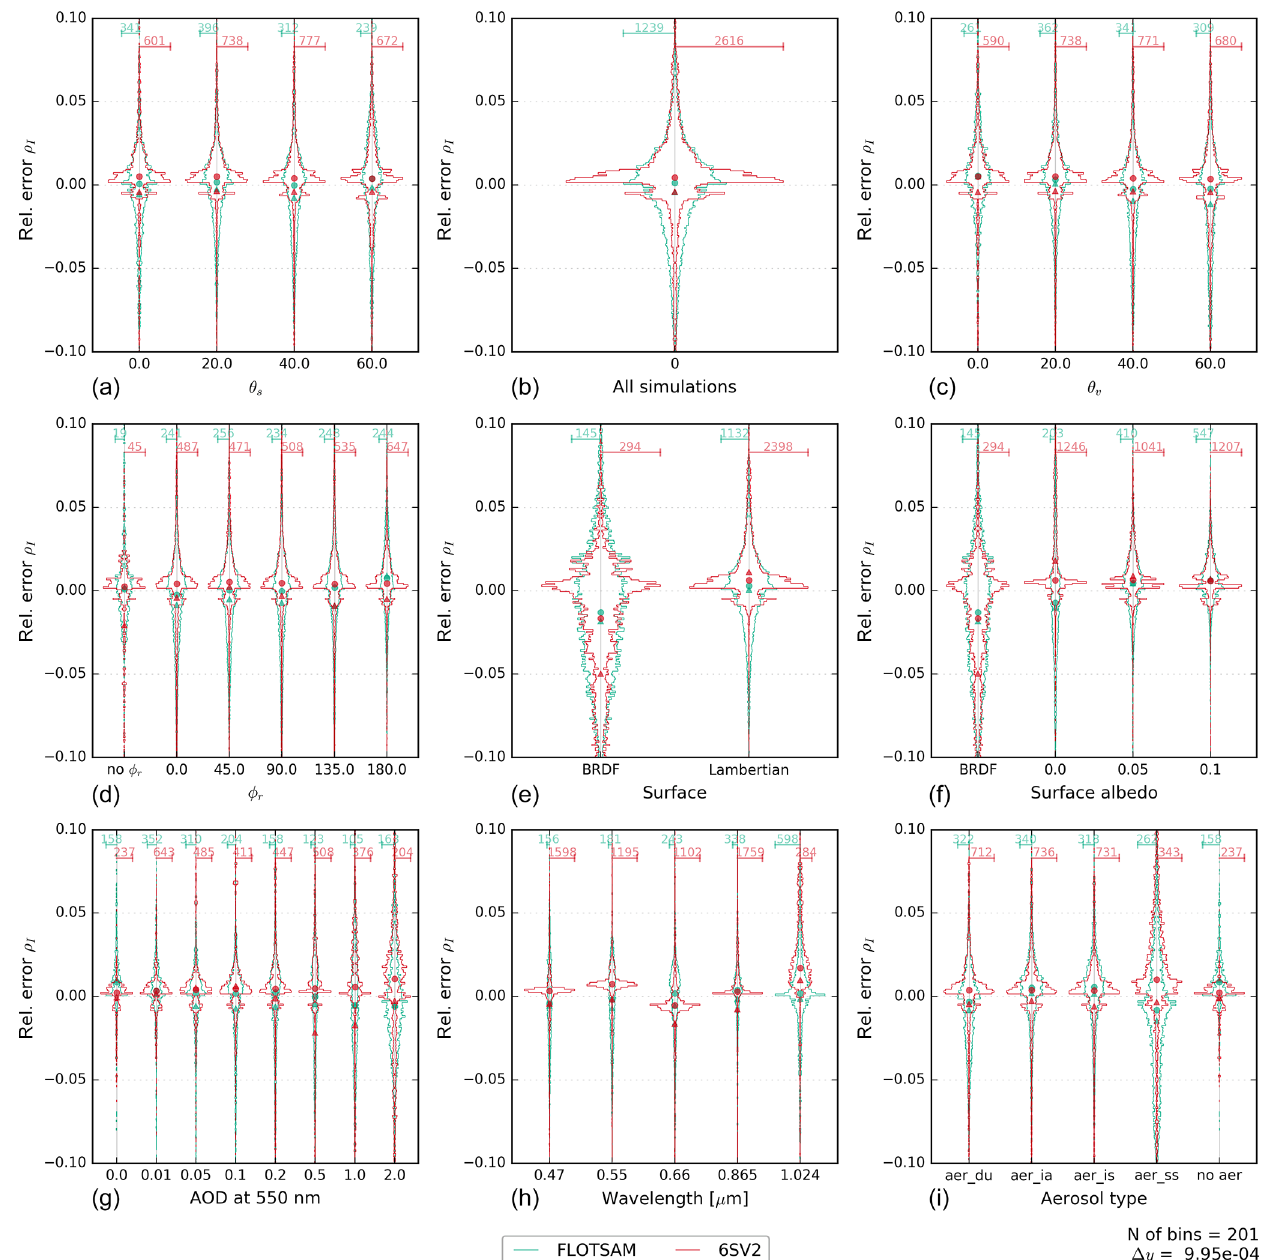
Figure 5. Same as Fig. 3 but for the relative error of the FLOTSAM and 6SV2 models against the vector version of VLIDORT. Please note the ± 10% relative error range of the y axis. The width of the classes is (cid:49)y = 9 . 95 × 10 − 4 . The number of cases outside the range is indicated in Table 4. Note that the scale used on the x axis is different for each violin plot but is the same for the two models within a violin